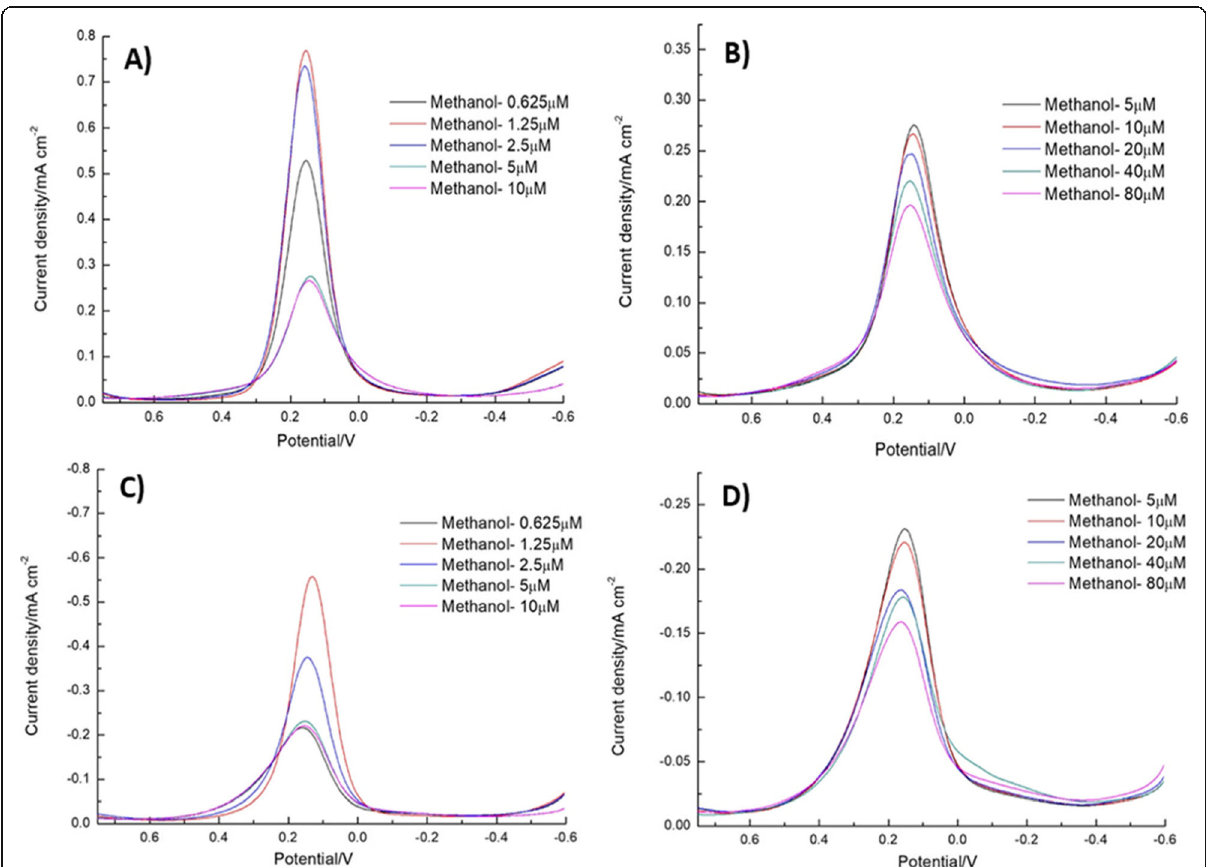
Fig. 9 a , c Displays the reduction and oxidation peak current depends on the concentration of PCBs 1.25 – 10 μ M dissolved in electrolyte